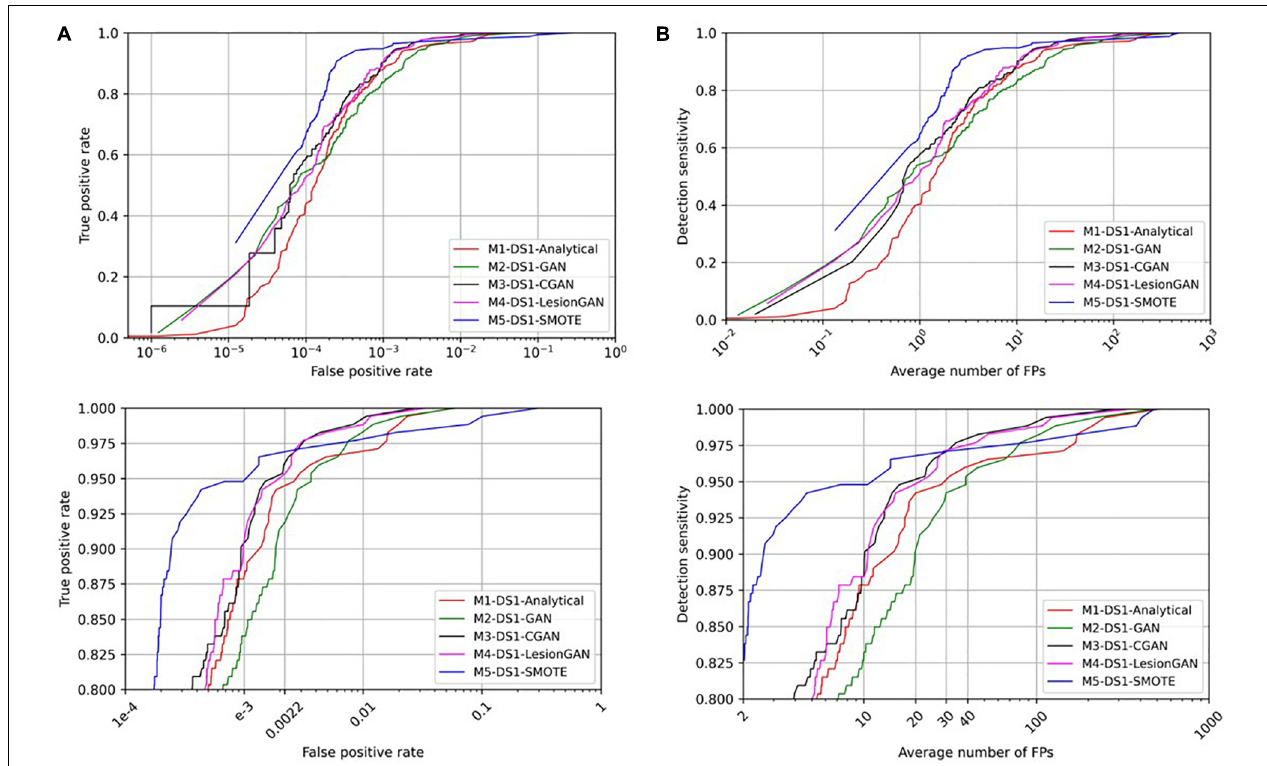
FIGURE 7 | Comparing receiver operating characteristic (ROC) (A) and free-response ROC (B) curves for cerebral microbleed classification on the whole SWI by 20,000 training samples. The bottom panel shows the zoomed version.